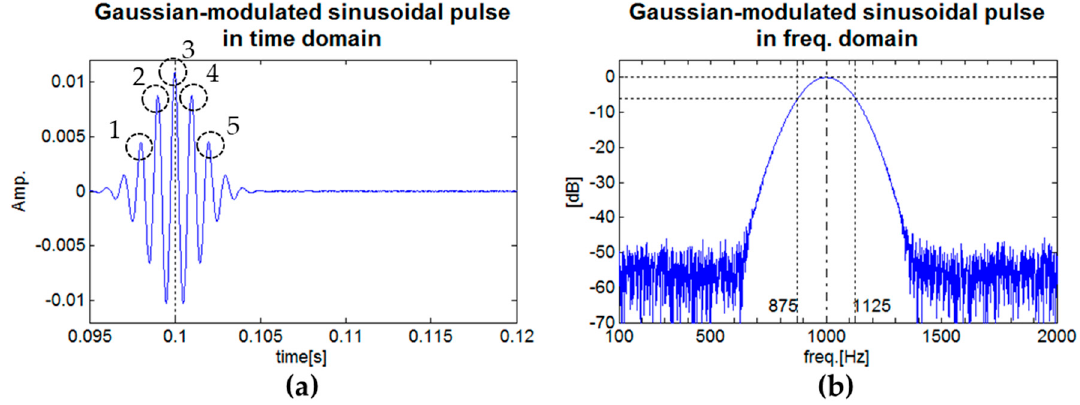
Figure 6. Gaussian-modulated sinusoidal pulse: ( a ) in the time domain; ( b ) in the frequency domain.